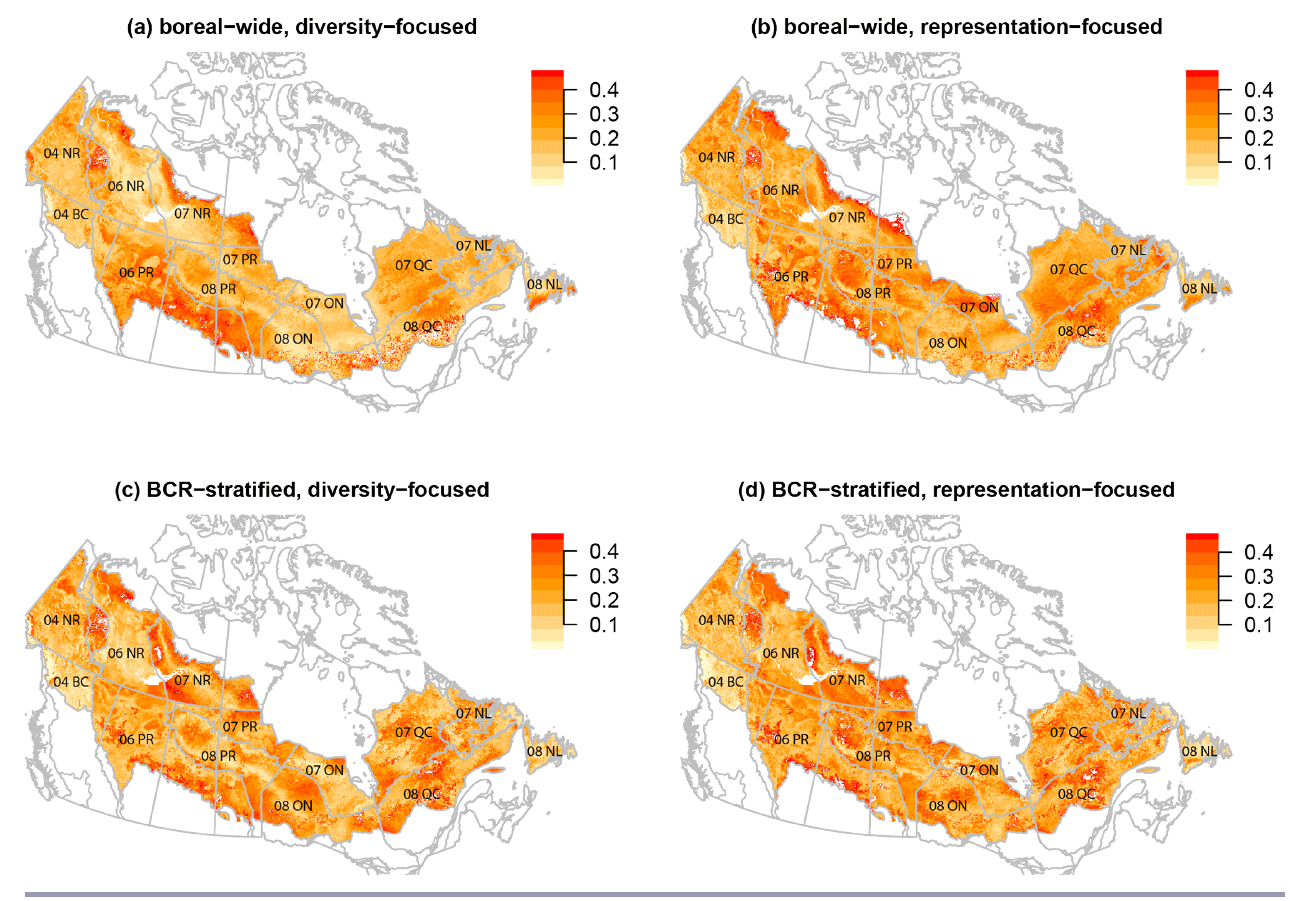
Fig. 7 . Standard deviation for four groups of 32 scenarios: boreal-wide, diversity-focused (a) and representation-focused (b), and bird conservation subregion-stratified diversity-focused (c) and representation-focused (d). Highest variation in Zonation ranks is in red; lowest variation is in light orange. BCR = bird conservation